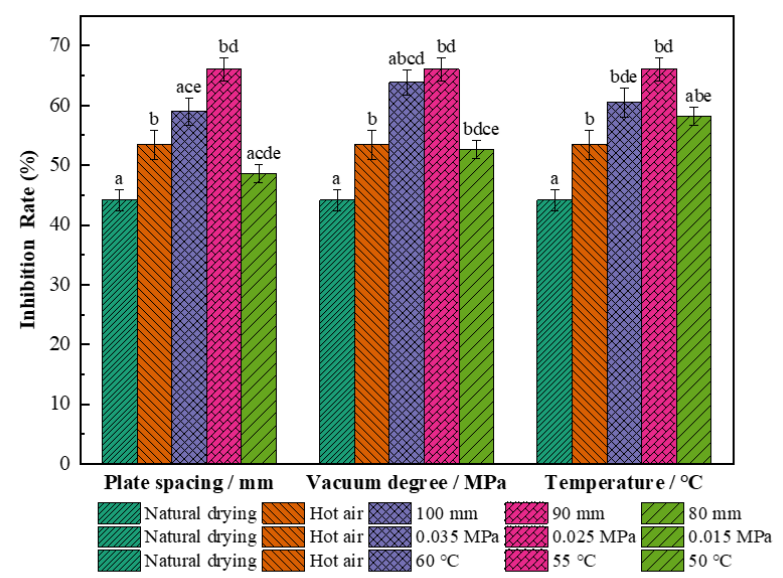
Figure 8. Antioxidant activity of L. barbarum under different drying conditions. Significant differences are represented by different letters ( p < 0.05).